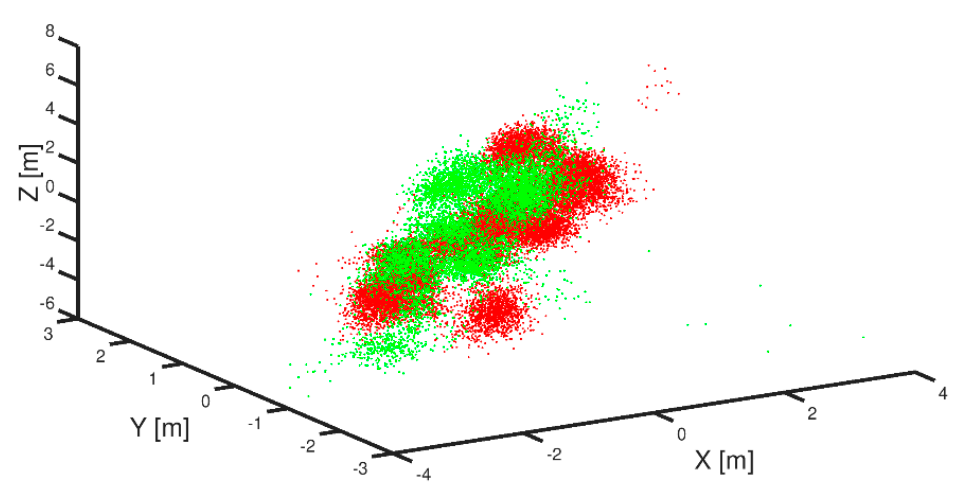
Figure 4. GNSS position accuracy records for the static measurement receiver outputs in open area conditions (red—LSQ algorithm, green—proposed new algorithm). Table 3. Comparison of the results of LSQ vs. median filter